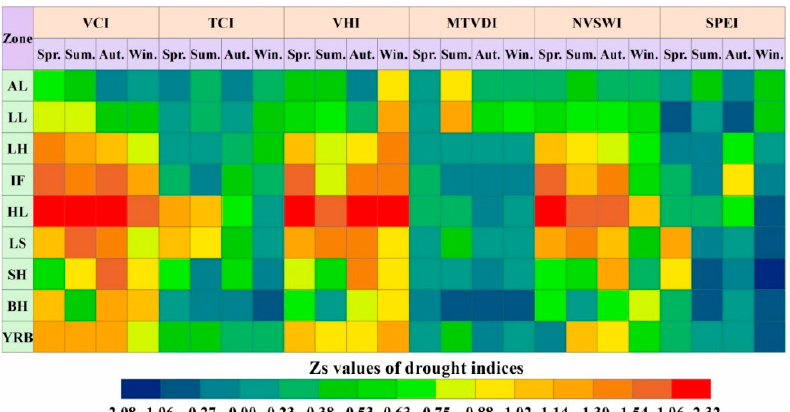
Figure 8. Z s values of drought indices during 2000–2015.